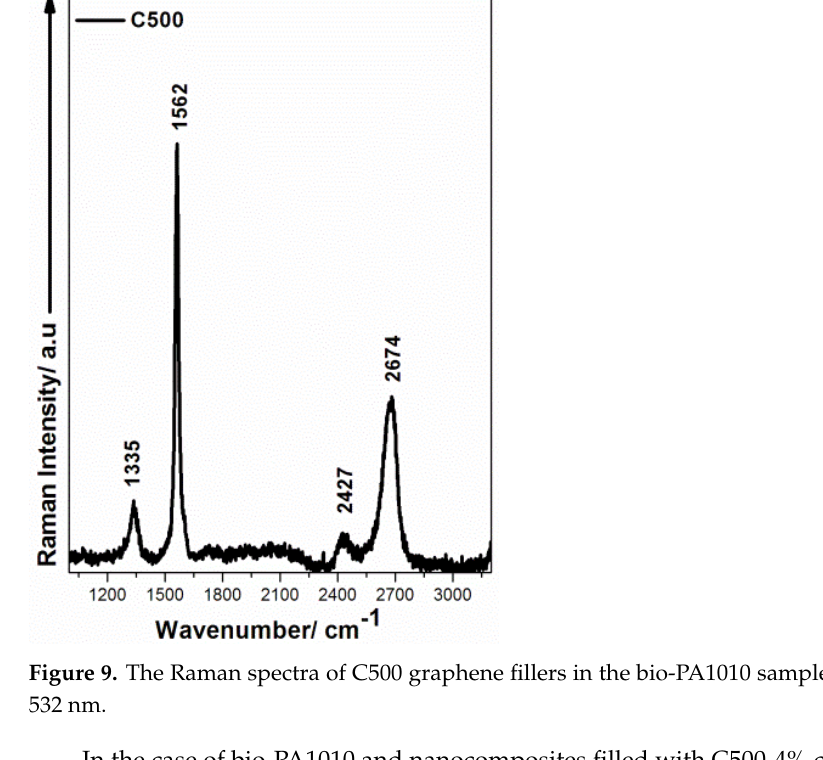
Figure 10. The Raman spectra of bio ‐ PA1010 nanocomposite filled with GNP C500 ‐ 4% thermally treated at 80 °C and 145 °C. We marked with * the bands that are less visible after the thermal treat ‐ ment.